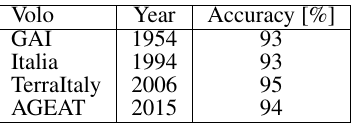
Table 6. Accuracy of the classification of the forest coverage class for the different aereal images.